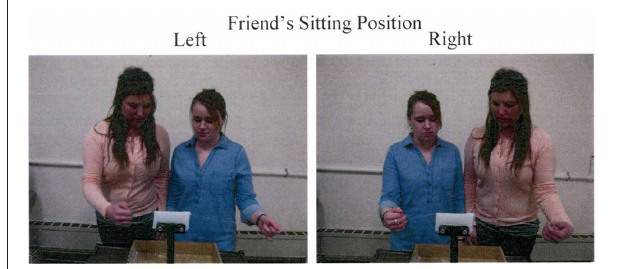
FIGURE 8 | Mean reaction times across all participants in different Experimental conditions of Experiment 4 when a friend was sitting to the participant’s left (A) and right (B). Error bars represent standard errors of the means. (Note: P’s = Participant’s; F’s = Friend’s). ∗ p < 0 . 05.